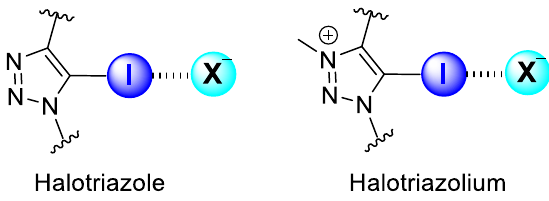
Figure 1. Common neutral (halotriazole) and cationic (halotriazolium) XB motifs for anion binding.